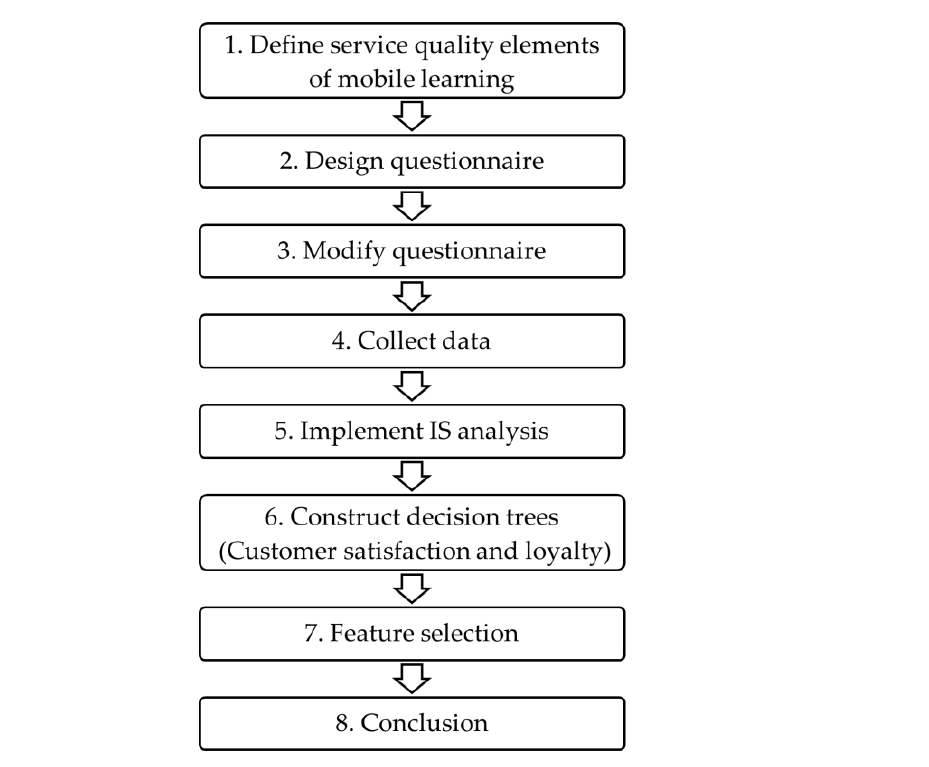
Figure 2. Implemental procedure of the IS-DT proposed